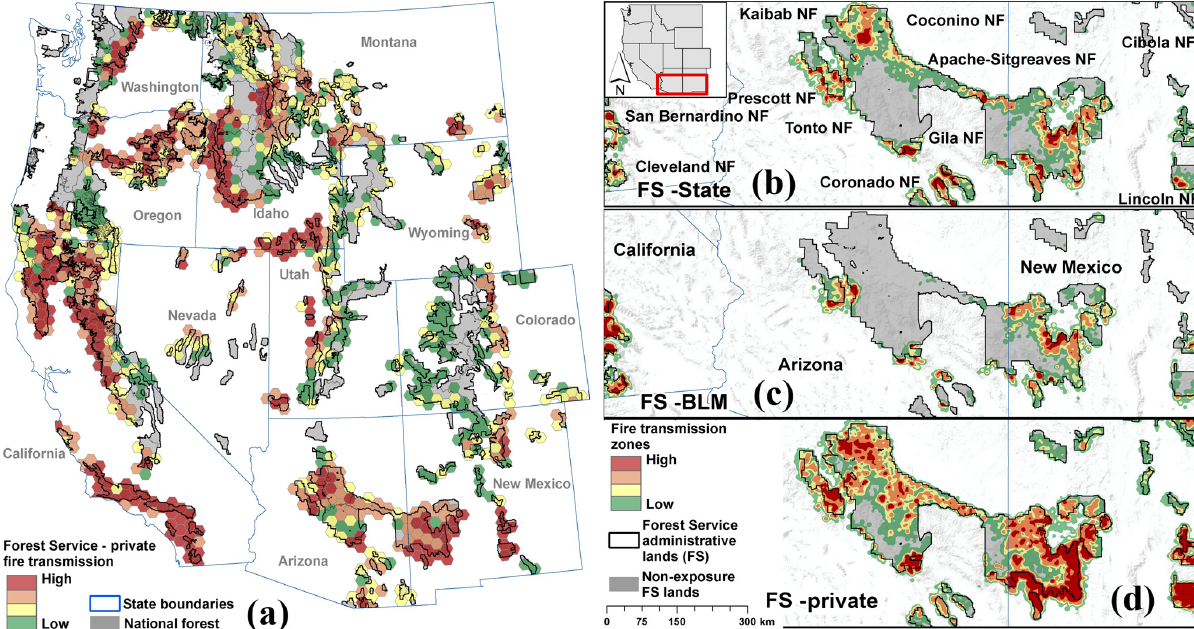
Figure 7. Cross-boundary wildfire from Forest Service administrative lands (FS) to private lands (a) . Grey areas indicate national forest lands where transmission to other land tenures is very low (high percent of self-burning fire). (b, c, d) Zoom in the southern part of the study area showing the detailed cross-boundary fire transmission zones and highlighting the differences among the three pairs of the largest land tenures of the western US: (b) FS–state; (c) FS–BLM; (d)